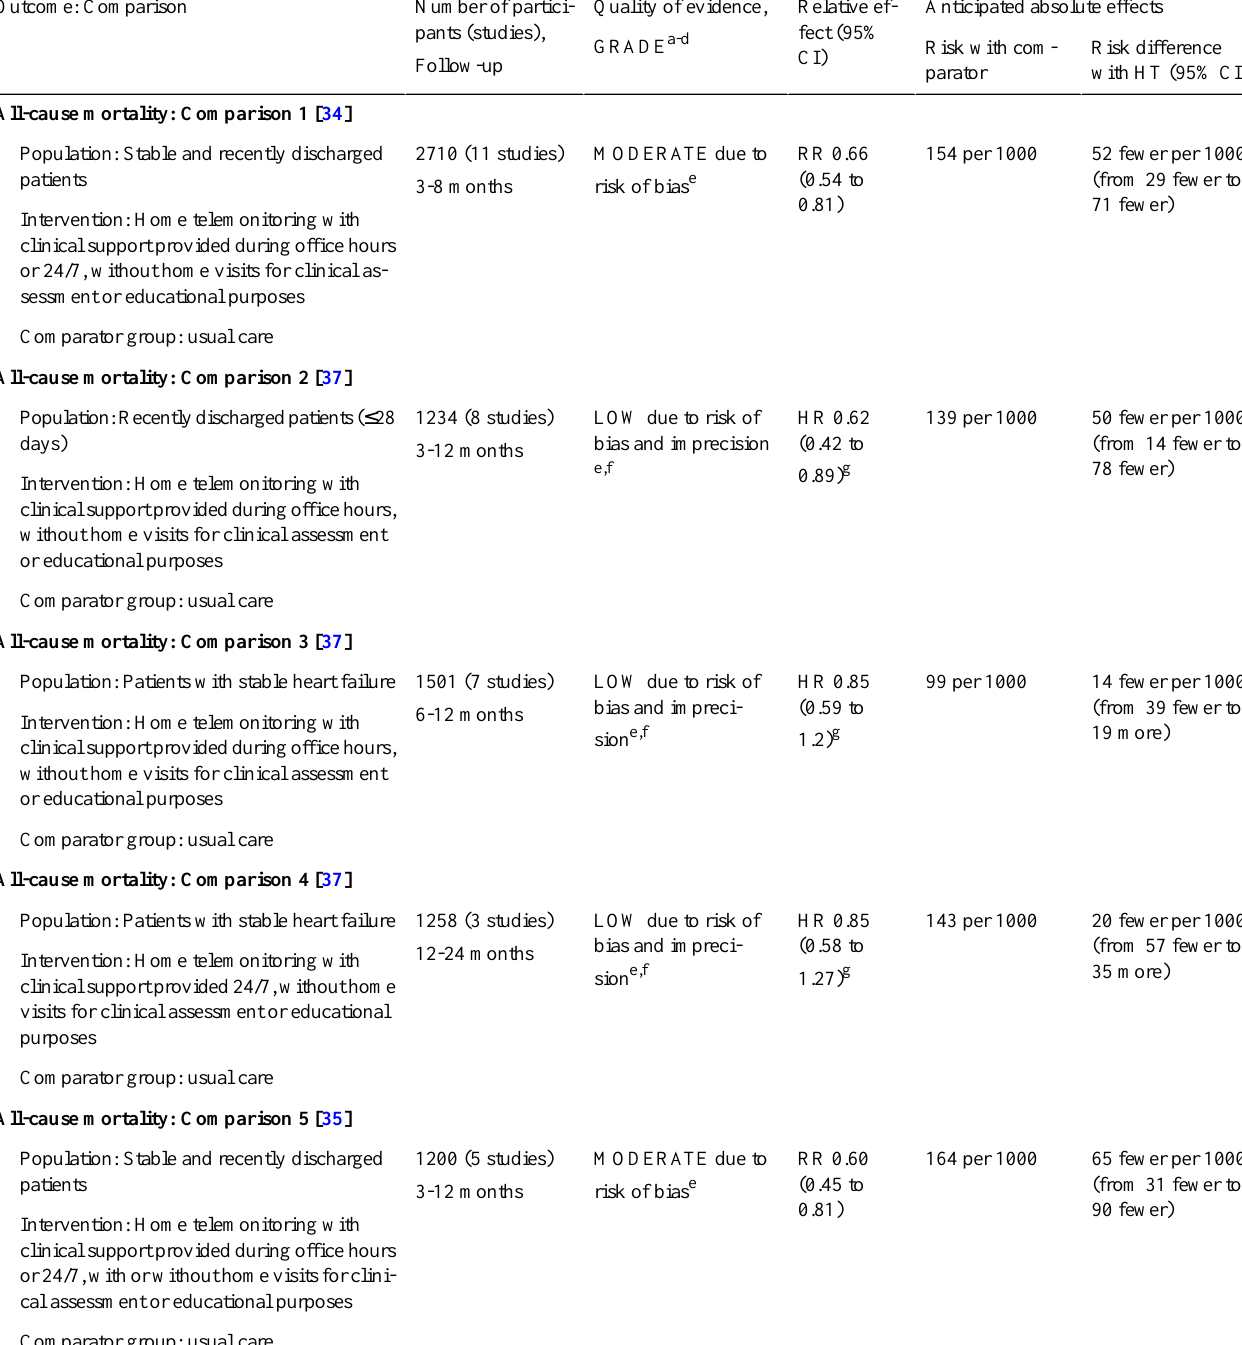
Table 7. Summary of findings from the meta-analyses with the most direct evidence in each group for the outcome of all-cause mortality.